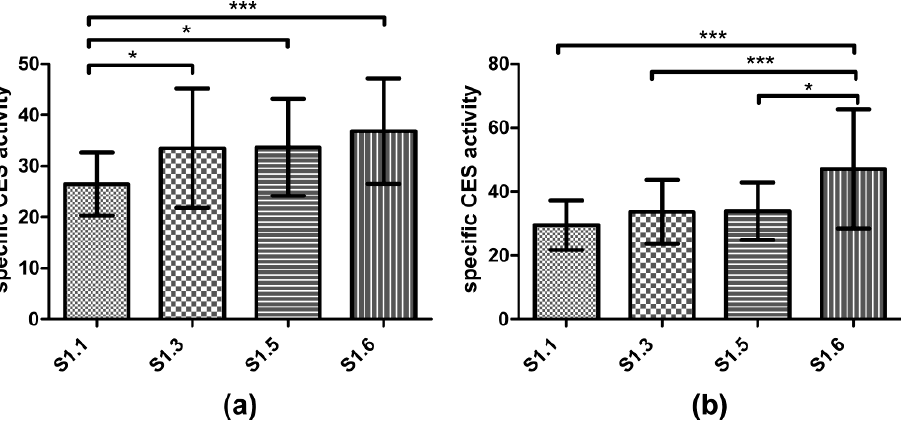
Figure 2. Specific carboxylesterase (CES) activity was measured in earthworms exposed to the first set of substrates for 48 h ( a ) and 14 days ( b ). Significant differences between substrates (ANOVA followed by Tukey) are labeled with * ( p < 0.05) and *** ( p < 0.001).